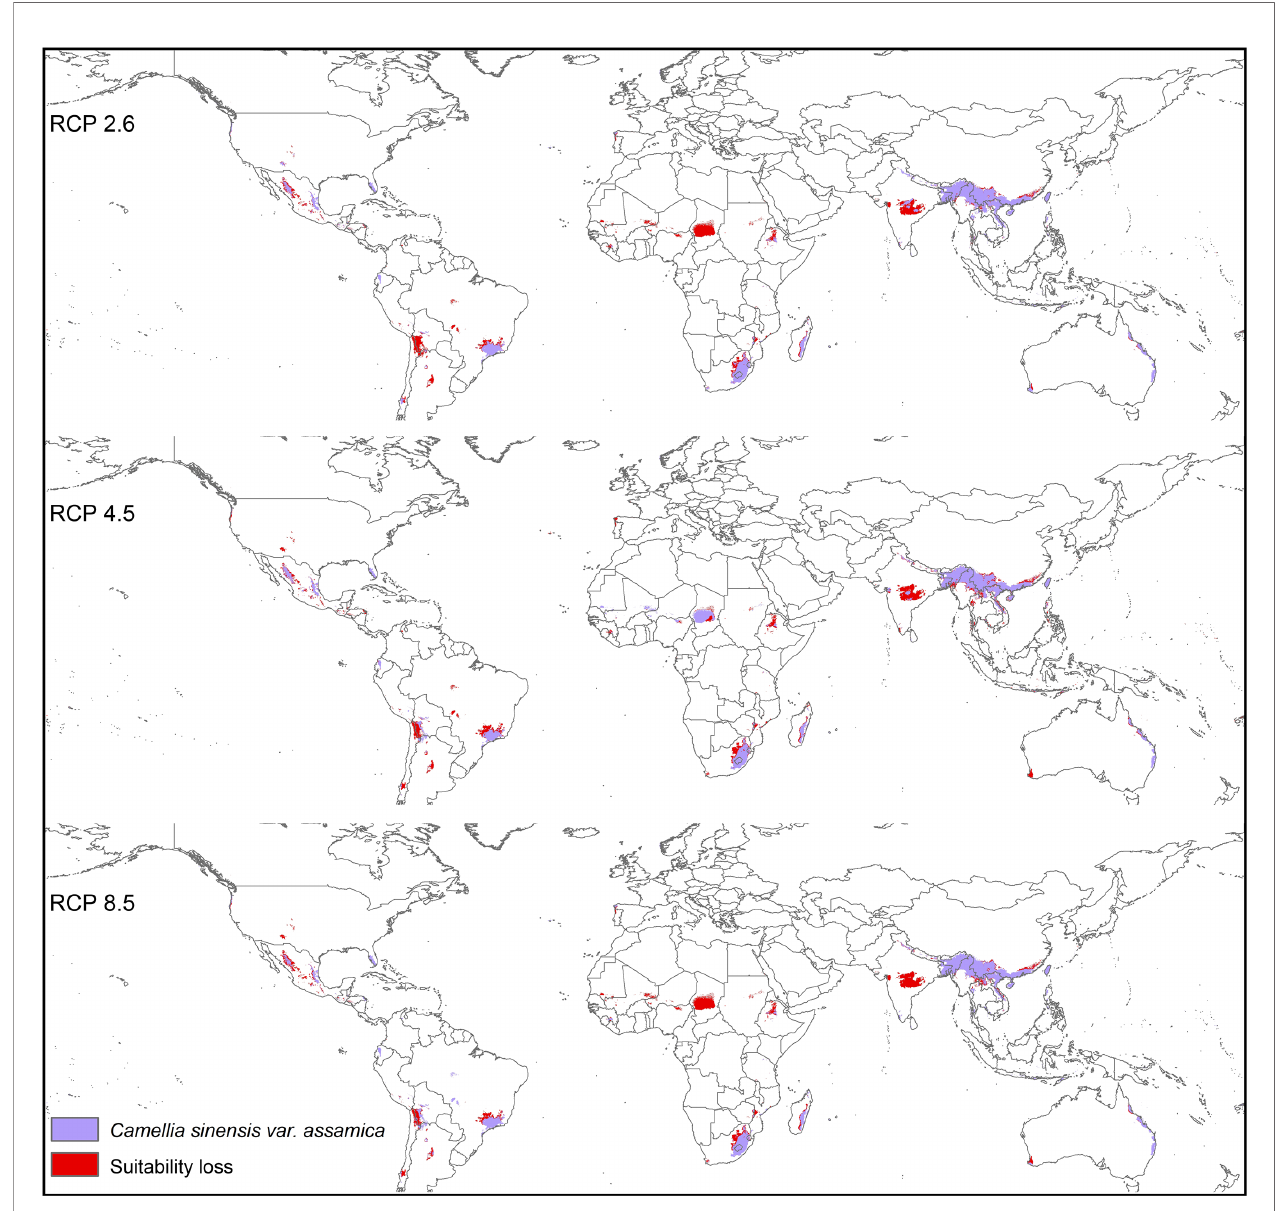
FIGURE 3 | Suitable areas for C. sinensis var. assamica growing under future climate scenarios with baseline suitable areas and losses by 2050 (purple represents the suitable areas, and red represents lost suitable